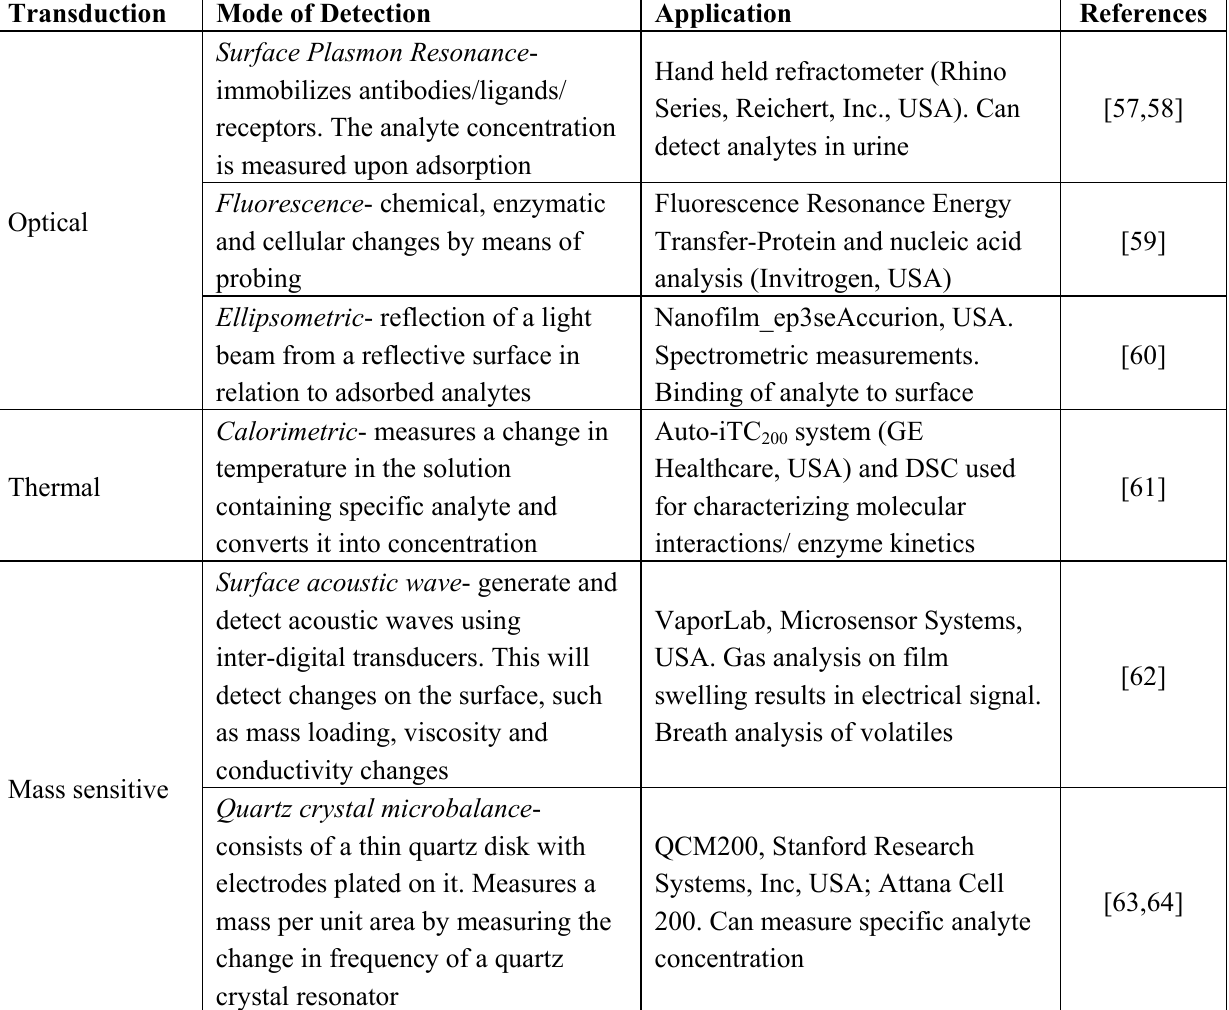
Table 1 is a classification of the various groups of biosensors (based on transduction signal) their mode of detection and application. Electrochemical and mass sensitive biosensor are the mostly used for detection and diagnosis of chronic disease as analytes can be obtained in a non-invasive manner. Table 1. Groups of biosensors based on transduction signal, their mode of detection and